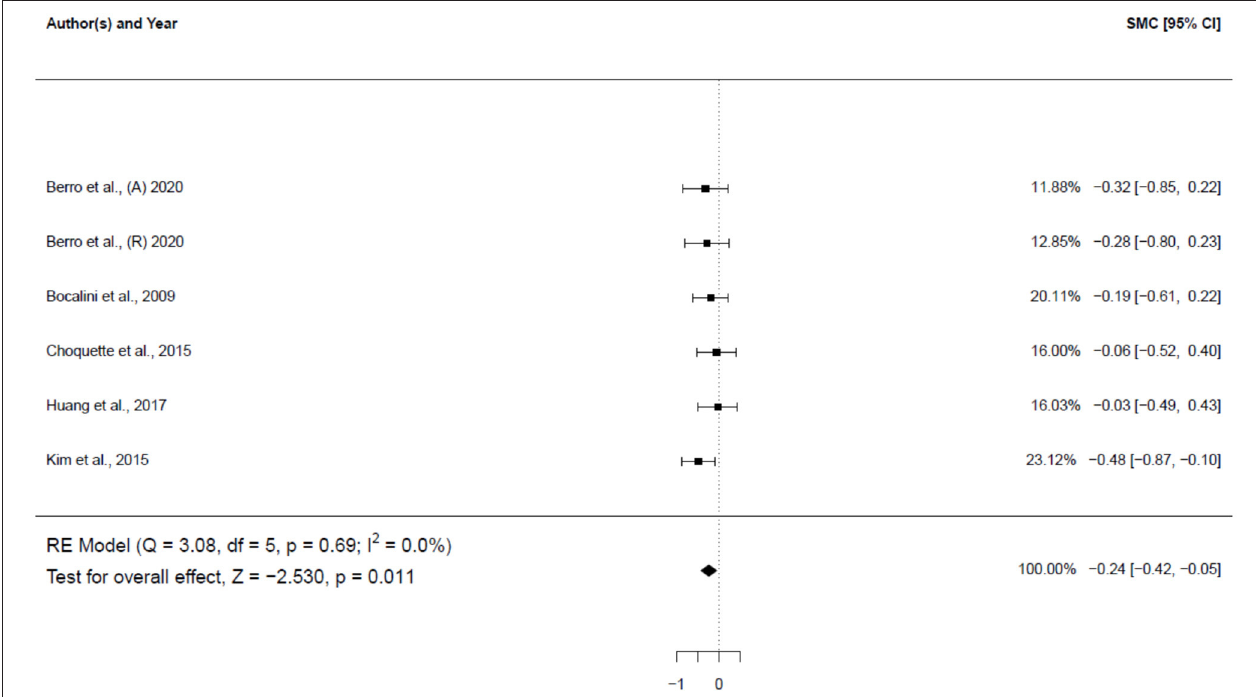
FIGURE 4 | Forest plot for the estimated standardized effect size changes in weight. The black squares represent the standardized mean difference, while the left and right extremes of the squares represent the corresponding 95% confidence intervals. The middle of the black diamond represents the overall standardized mean difference, while the left and right extremes of the diamond represent the corresponding 95% confidence intervals. SMC, standardized mean change A, aerobic; R,